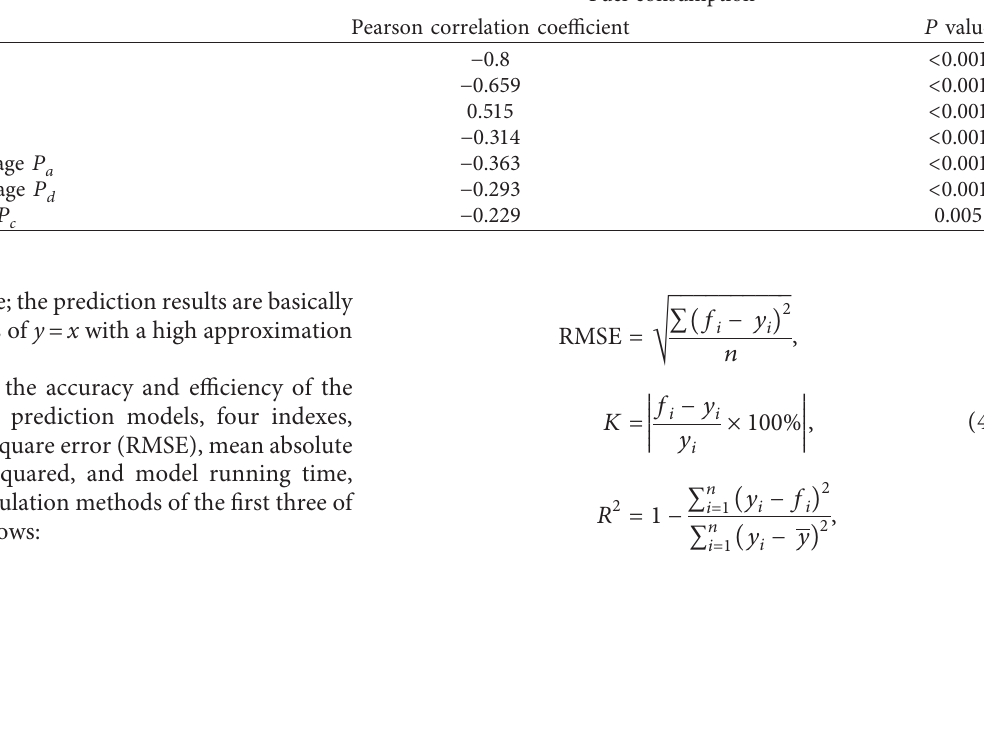
Fuel consumption Pearson correlation coefficient P value −